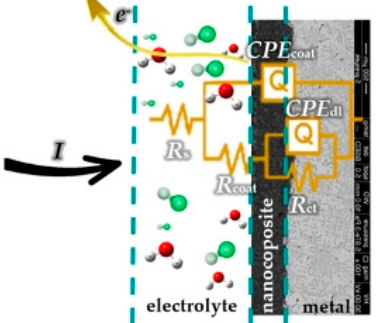
Figure 8. Equivalent circuit model employed to fit the impedance data. The OCP measurement showed an insignificant change in the electrode potential.